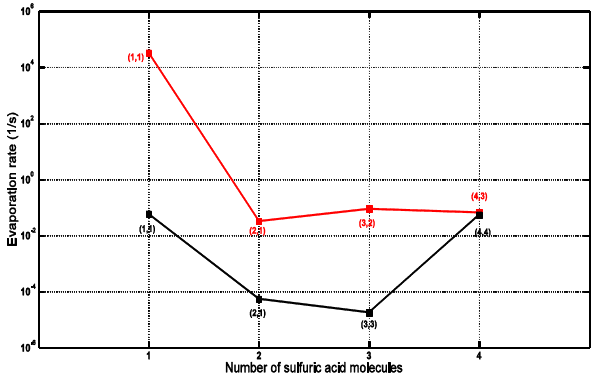
Fig. 5. Evaporation rates for the most stable clusters independently of the number of bases in it including non-monomer evaporation, composition of each cluster is indicated in parenthesis (acid:base), black line correspond to DMA containing clusters and red line to ammonia containing clusters.